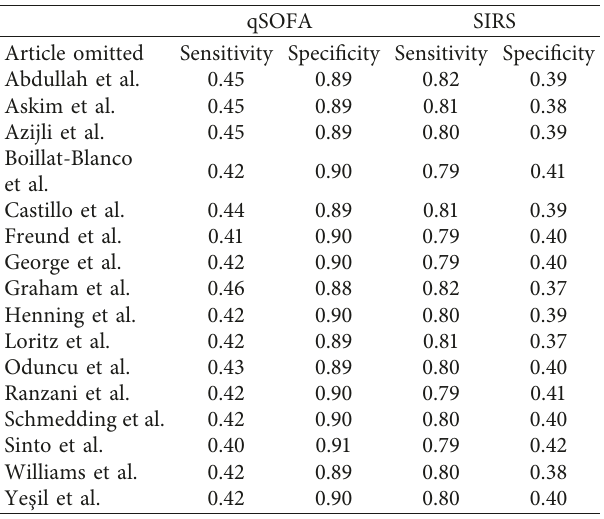
Table 3: Sensitivity analysis of sensitivity and specificity for qSOFA and